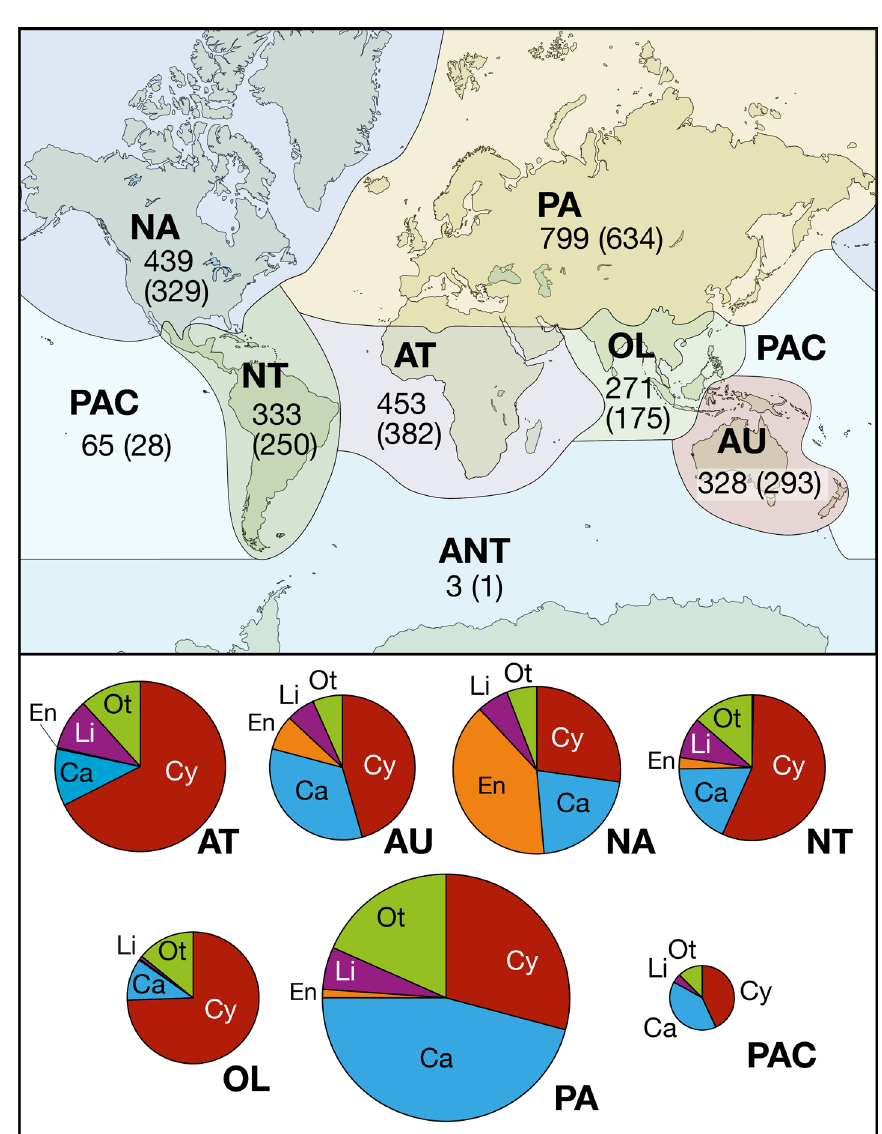
Fig. 1. Numbers of non-marine ostracod species reported in each zoogeographical region, endemic species in parentheses, and proportions of species in non-marine families in each region. Abbreviations: Cy = Cyprididae; Ca = Candonidae; En = Entocytheridae; Li = Limnocytheridae; Ot = other families. Sizes of pie charts are proportional to the number of species reported from